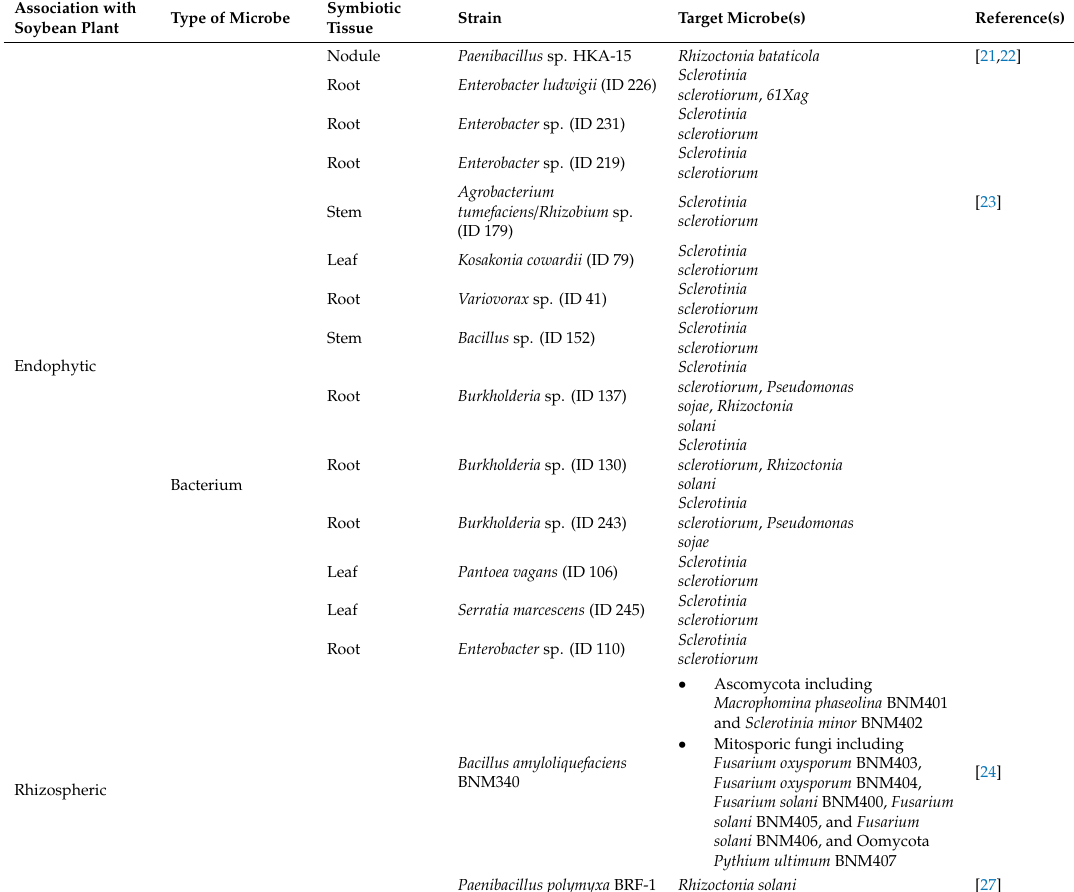
Table 5. Soybean-associated microbes that exhibit antimicrobial activities. Association with Soybean